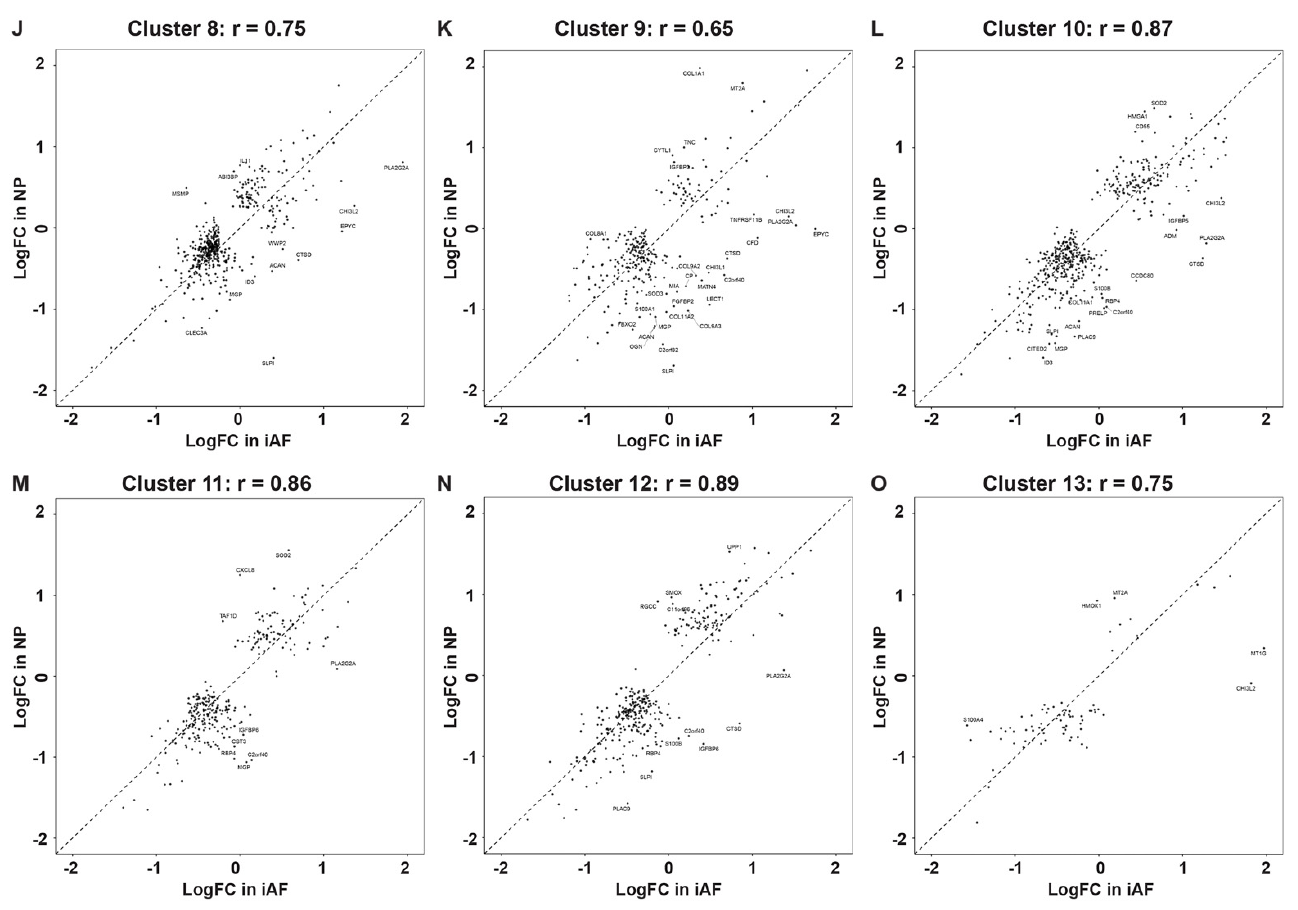
Figure 3. Correlation between changes in gene expression in iAF and NP cells from total RNA and per cluster. Scatter plots showing correlational analysis between DEGs in iAF and NP cells ( A ) all together and ( B – O ) in each of the 14 clusters (0–13). Pearson correlation coefficients (r) between iAF and NP were calculated using the log fold change (logFC) values of genes that are differentially expressed in cell type.